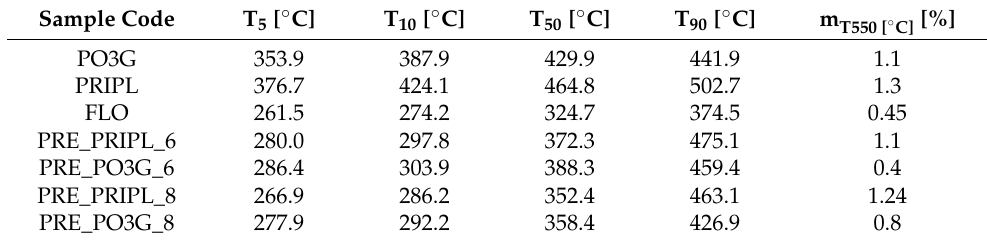
Table 3. Thermal decomposition characteristics of the obtained bio-based